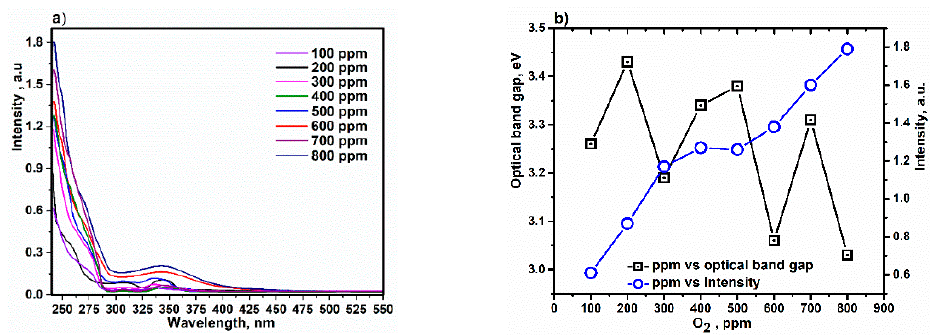
Figure 7. ( a ) Absorption spectra and ( b ) content of oxygen versus absorption intensity and optical band gap of the vapor-coated composite on film.